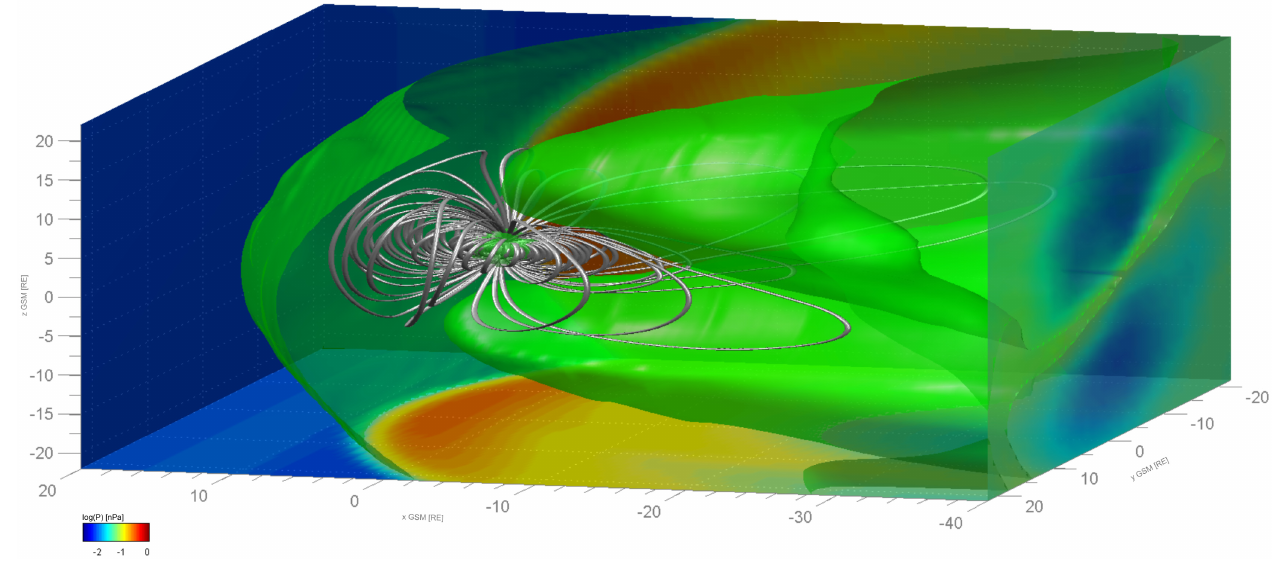
Fig. 4. 3-D representation of the global magnetic field lines of a BATS-R-US run for the 8 October 2005; 08:05 UT. The visualisation is done in a bounding box of 40 R E to 20 R E in x -direction and − 22 R E to 22 R E in y - and z -direction with 1.5 Million interpolated cells. The 2-D slices show the colour coded dynamic pressure in a logarithmic scale. The volume plots show the two plasma cavities above and beneath the neutral sheet and the plasma concentration at the bowshock. The streamtubes represent the closed fieldline